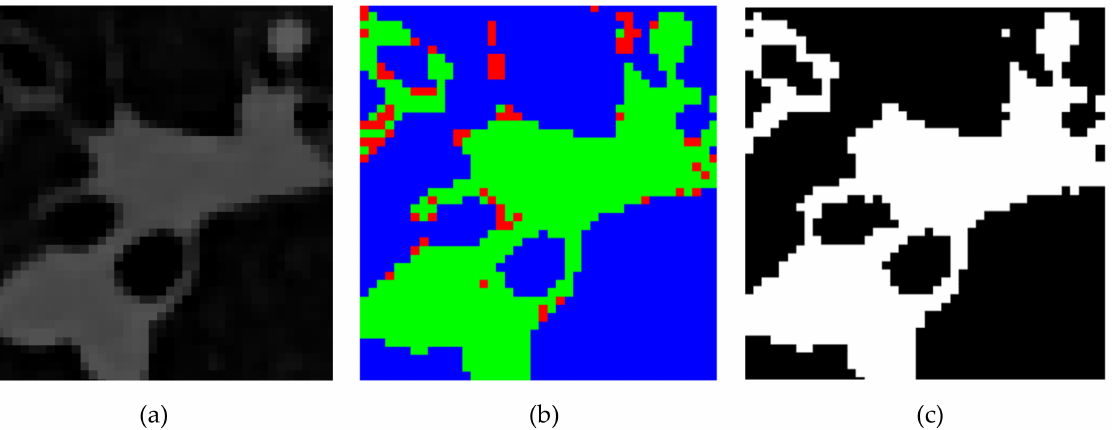
Figure 5. Pulmonary airway wall repair. Here, ( a ) is the original image, ( b ) is the score given according to three-stage segmentation; blue (air) is 0 point, red (uncertain) is 1 point, and green (airway wall and blood vessel structures) is 2 points, and ( c ) is the result of repair after the mask weight score is applied.